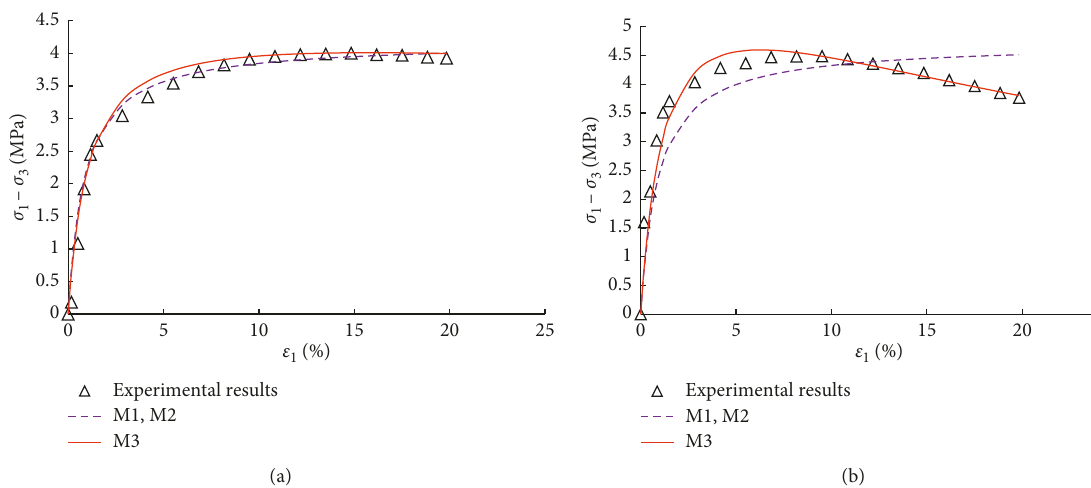
Figure 9: Deviatoric stress-strain relationship fitting results for each model at − 3 ° C. (a) T � − 3 ° C, σ 3 � 1.0MPa. (b) T � − 3 ° C, σ 3 � 8.0MPa.